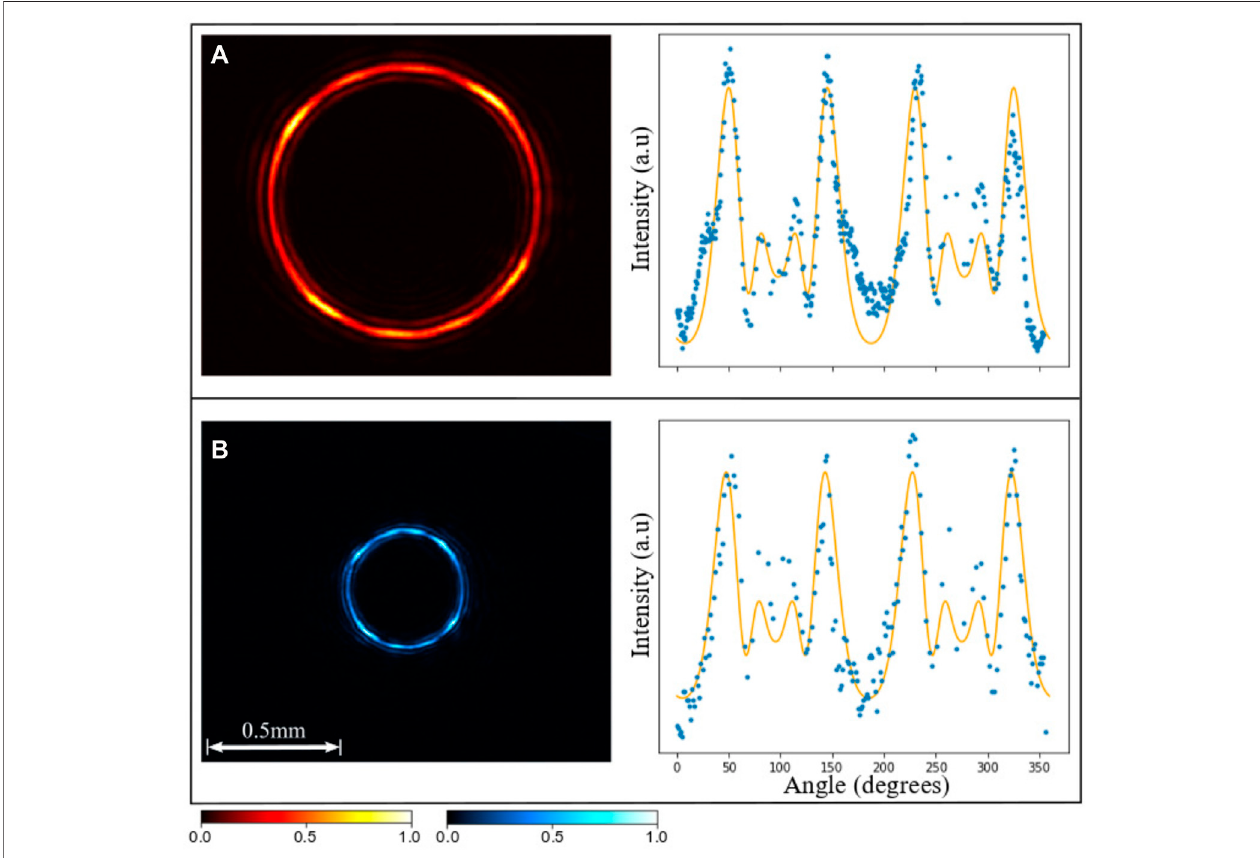
FIGURE4| Angular spectraofthe HM-Gpump beam and the CBLwhen Mathieumodes oforder 4were transferred fromthe red totheblue beam throughFWM. Ontheleft, (A) showsanimageofHM-GtakenusingaCMOScameraatitsFourierplane,andontherightdisplaysthebest fi t(orange)totheexperimentaldata.Thedata corresponding to the CBL are depicted in (B)